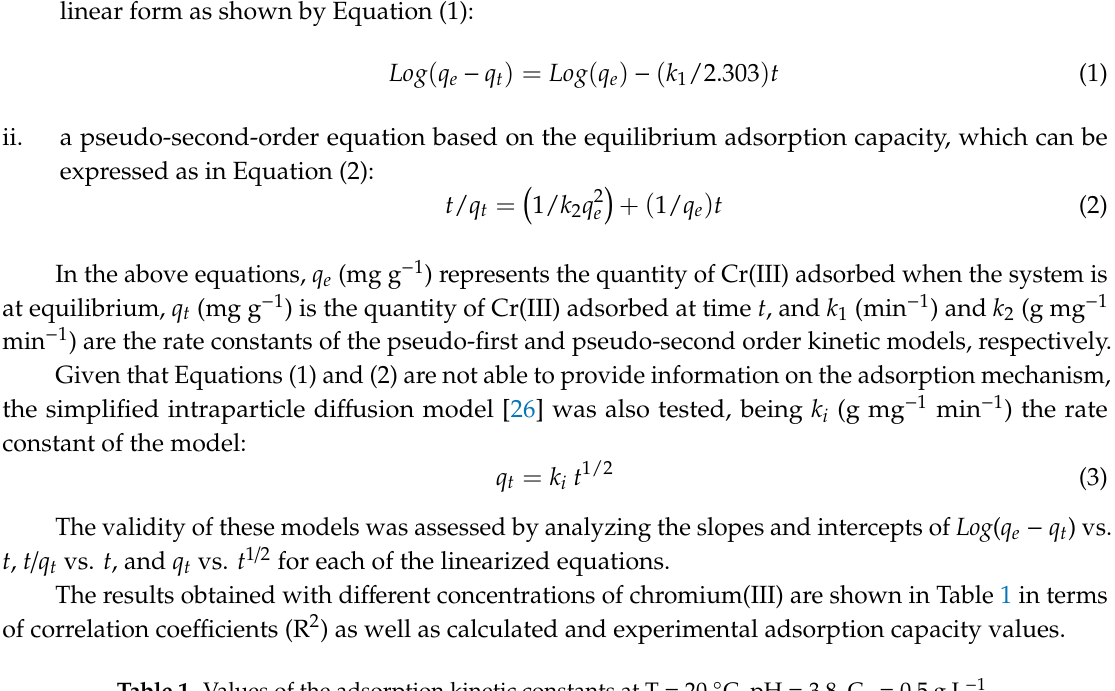
Table 1. Values of the adsorption kinetic constants at T = 20 ◦ C, pH = 3.8, C 0 = 0.5 g L − 1